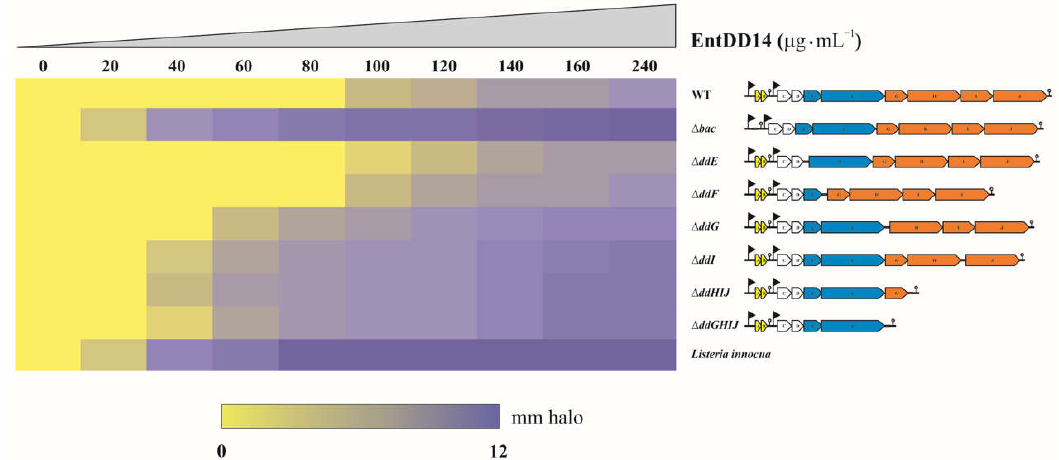
Figure 3. Heatmap profile of Enterococcus faecalis 14 and its mutant strains in GM17 broth in the presence of extracellular EntDD14. The data are the means of at least three independent experiments.